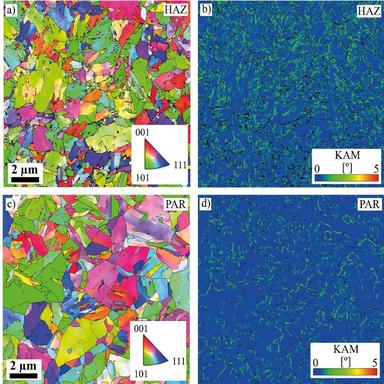
EBSD inverse pole figure and kernel average misorientation maps of the HAZ (a,b) and parent material (c, d).